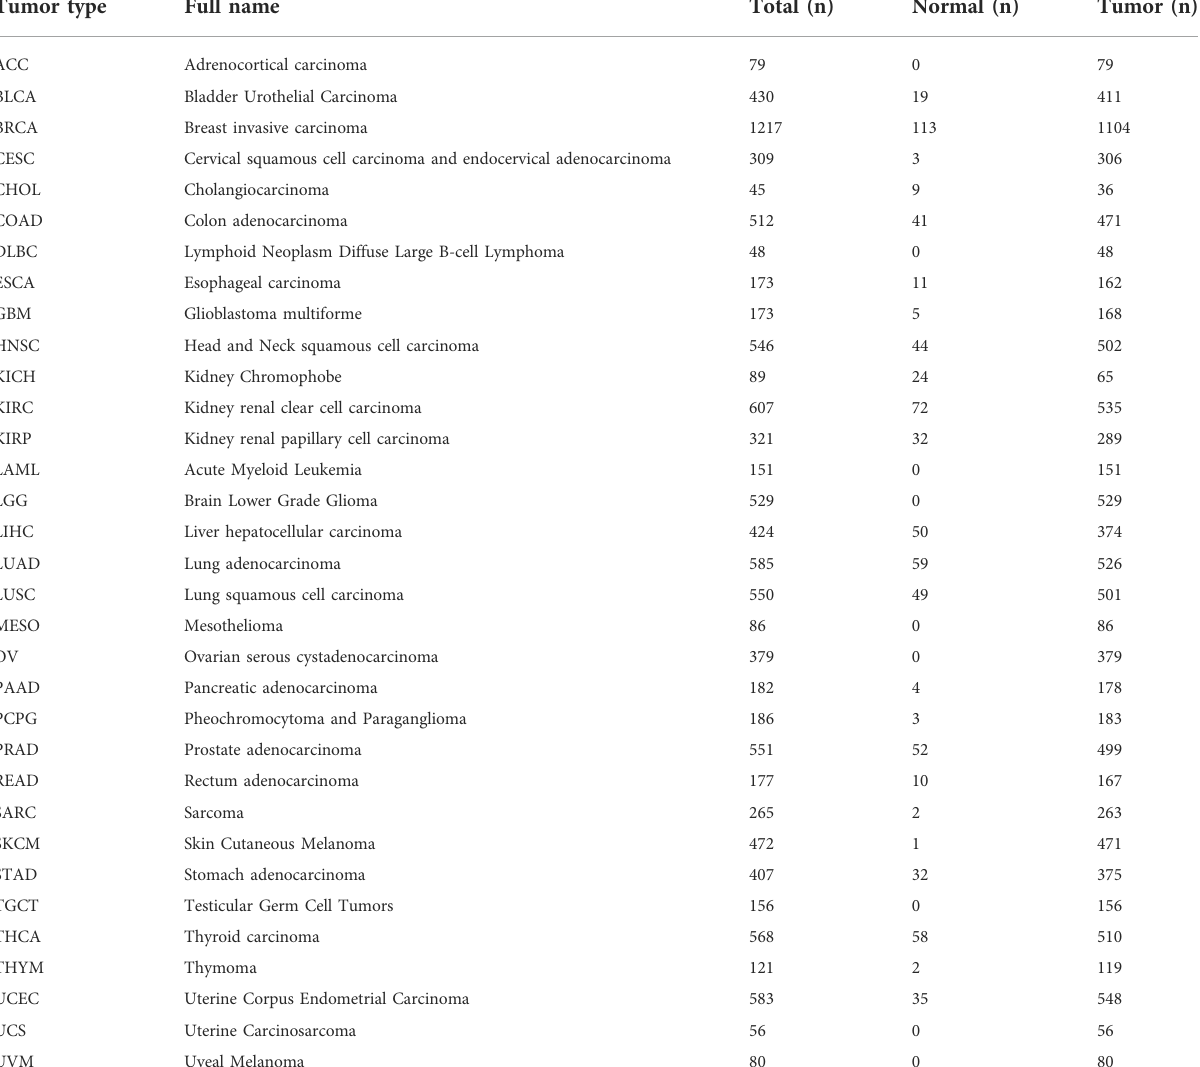
TABLE 1 Tumor type classi fi cation and patient number. Tumor